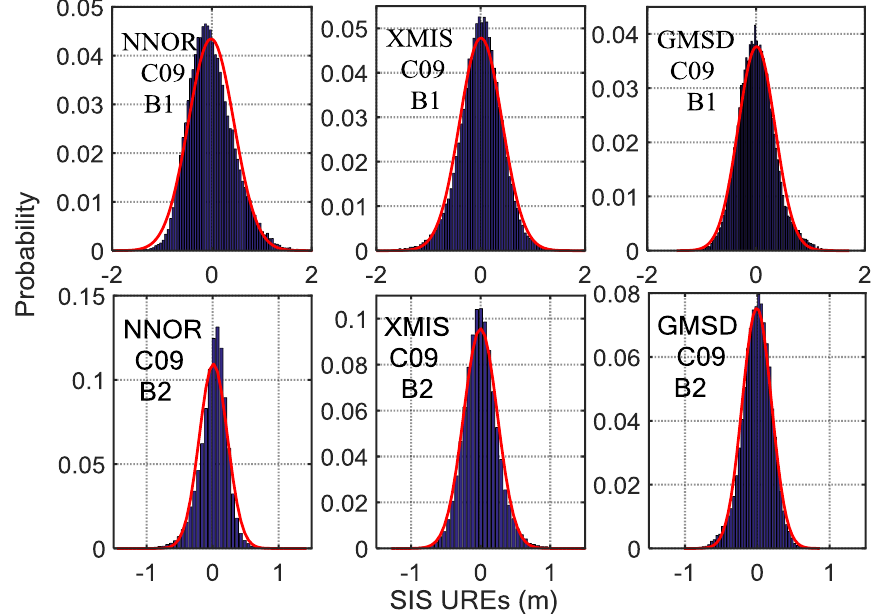
Figure 8. The histograms of C09 SIS UREs (m) after eliminating the trend term covering fourteen experimental days, overlaid with empirical normal probability-density function (PDF) curves (in red). Six subplots, arranged in two rows and three columns, show the results for three tracking stations (left column, NNOR; middle column, XMIS; right column, GMSD) and two frequencies (upper row, B band; bottom row, B band).